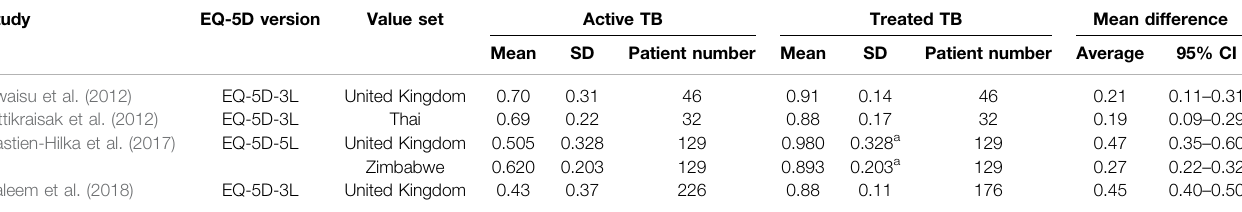
TABLE 3 | Mean differences of EQ-5D before and after tuberculosis